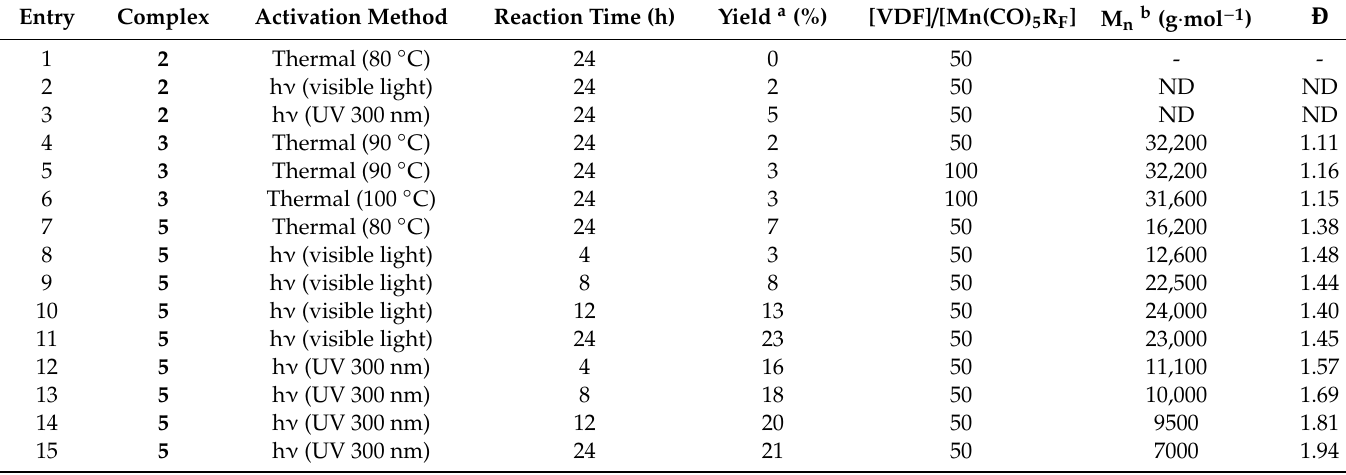
Table 1. Results for the VDF polymerization initiated by the thermal or photochemical activations Table 4. Experimental conditions and results of the polymerization of VDF (1.5 g) in the presence of [Mn(R F )(CO) 5 ] initiators.